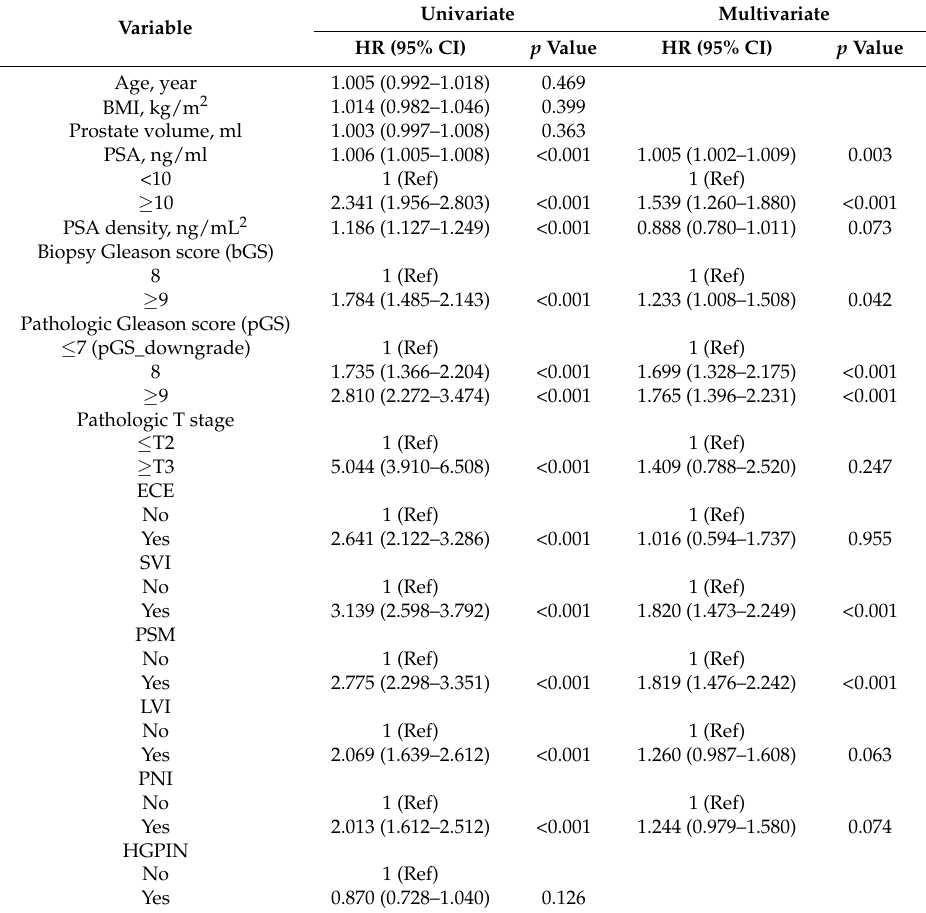
Table 3. Univariate and multivariate analyses of factors associated with biochemical recurrence. Variable